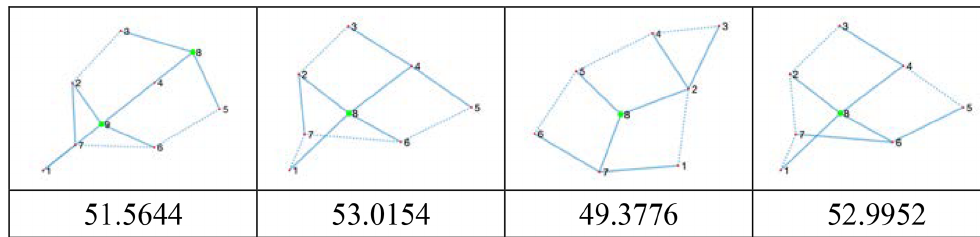
Figure A2. A total of four displacement graphs of 7bar 2 DOF planetary gear trains.